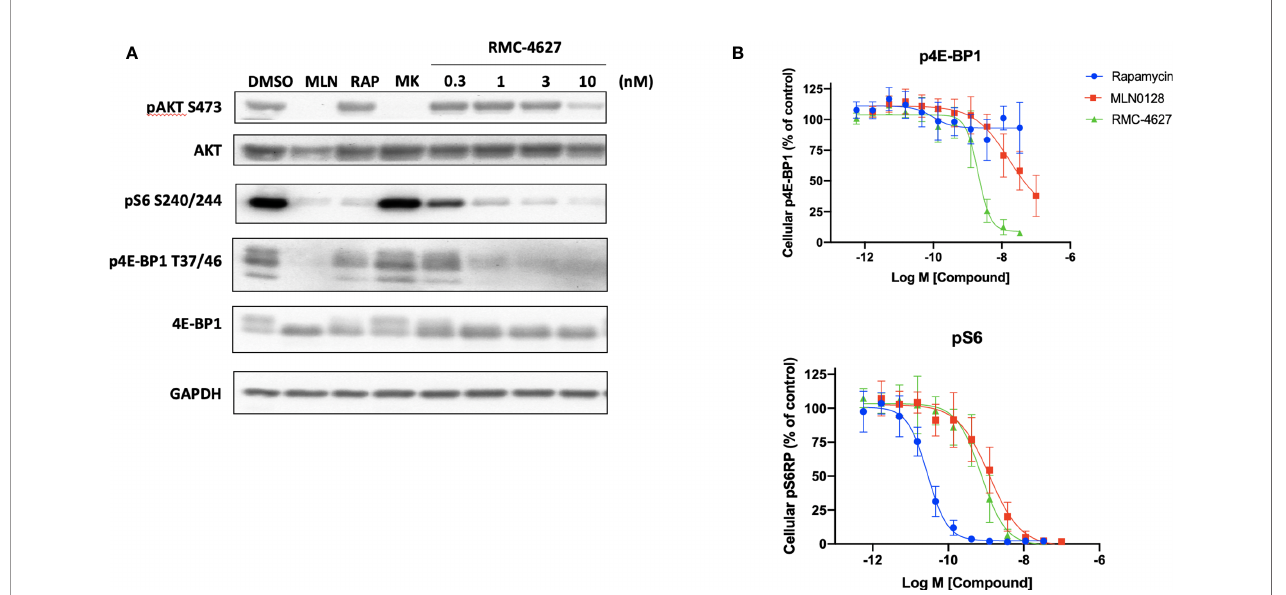
FIGURE 1 | RMC-4627 selectively inhibits phosphorylation of mTORC1 substrates in human B-ALL cells. (A) Immunoblot analysis of cell lysates from SUP-B15 cells incubated with the indicated compounds for 2 hours (MLN: MLN0128, 100 nM; RAP: rapamycin, 10 nM; MK: MK2206, 100 nM). Similar results were observed in two additional experiments. (B) Levels of p4E-BP1 T37/T46 and pS6 S240/S244 determined by MesoScaleDiscovery (MSD) for cell lysates from SUP-B15 cells incubated with the indicated compounds for 2 hours. Data are expressed as mean percent of MSD signal (3 biological replicates) normalized to vehicle control, with error bars representing